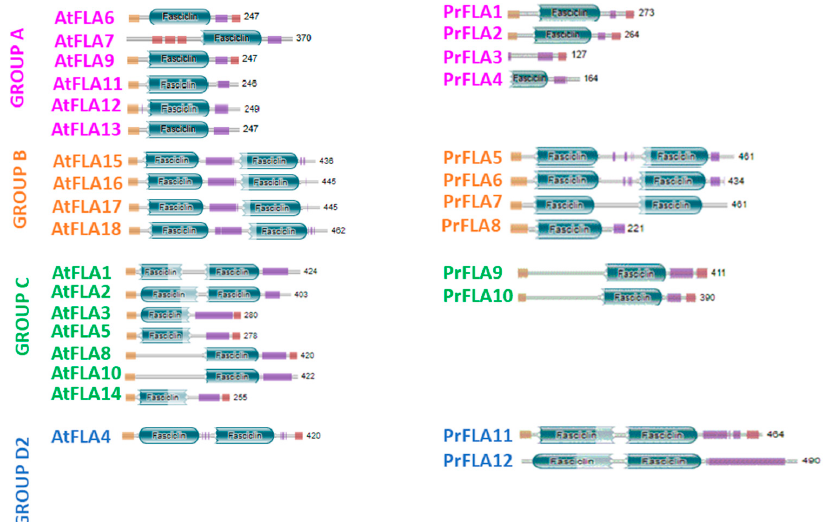
Figure 2. Analysis of domains and conserved motifs within FAS proteins identified in radiata pine in comparison with A. thaliana sequences. The search for domains and conserved motifs was performed with Pfam. The signal peptide is indicated in yellow, green capsules correspond to Fasciclin domains, binding to transmembrane (TM and signal peptide) is indicated in red, could be GPI anchor, and Disorder or PA motifs of AGP are indicated in lilac.